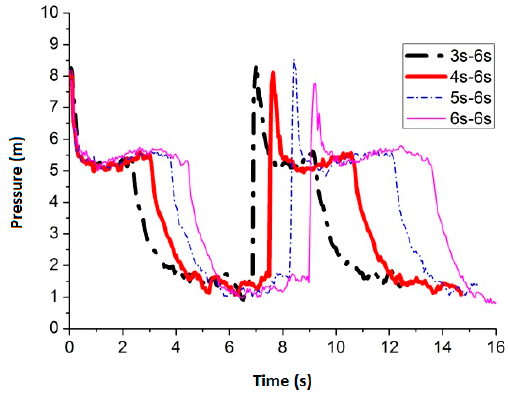
Figure 16. The four best pressure values (rectangular nozzle on top of the pipe).